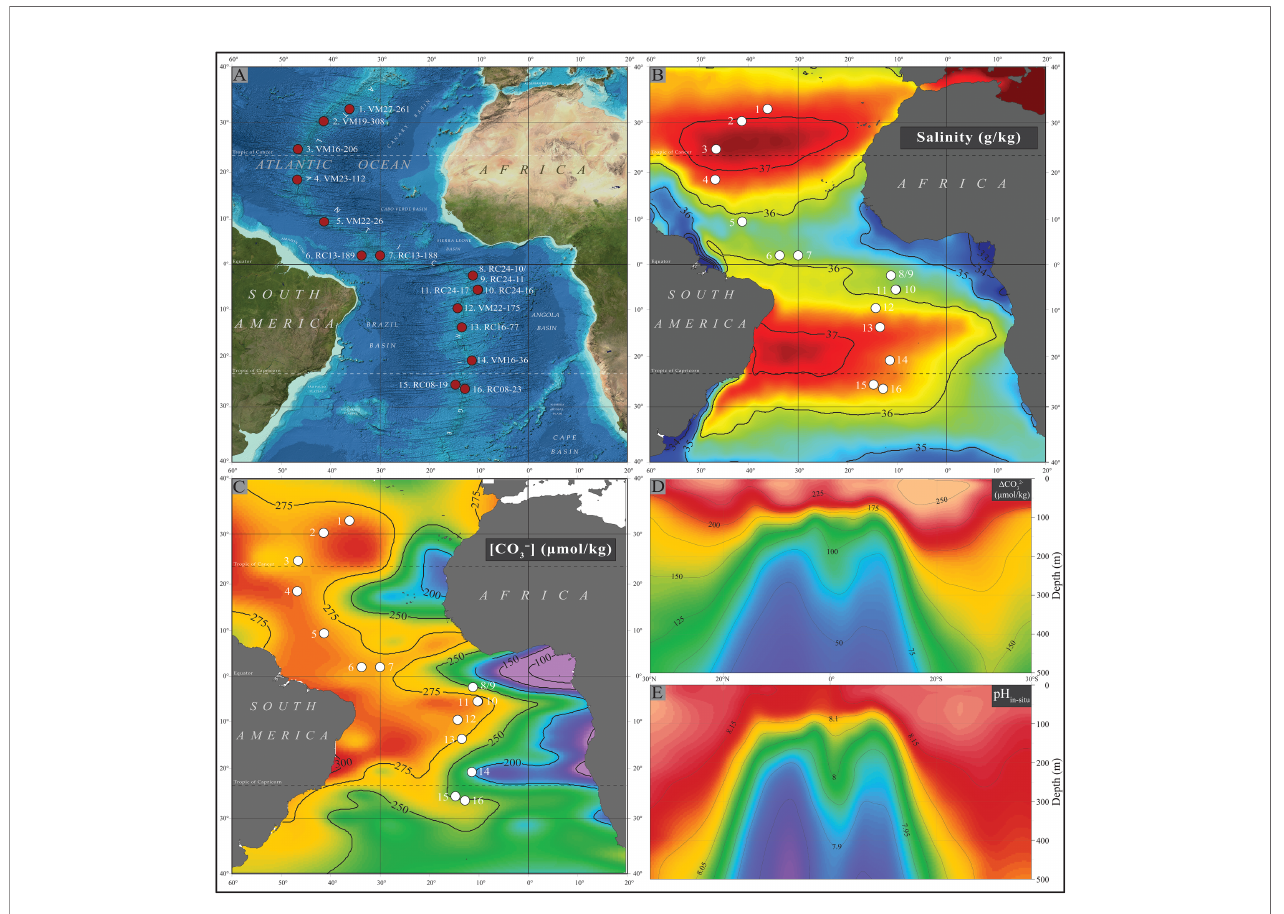
FIGURE 1 | (A) Locations of the 16 core-top samples for this study; (B) mean annual SSS (PSU). Data from the World Ocean Atlas 2013; (C) preindustrial surface seawater [CO 2 − 3 ] ( m mol/kg); Latitudinal hydrographic sections of the central Atlantic showing preindustrial: (D) water column pH and (E) seawater saturation state with respect to calcium carbonate D CO 2 − 3 estimates from GLODAP v.1 data corrected for anthropogenic dissolved inorganic carbon (Key et al.,